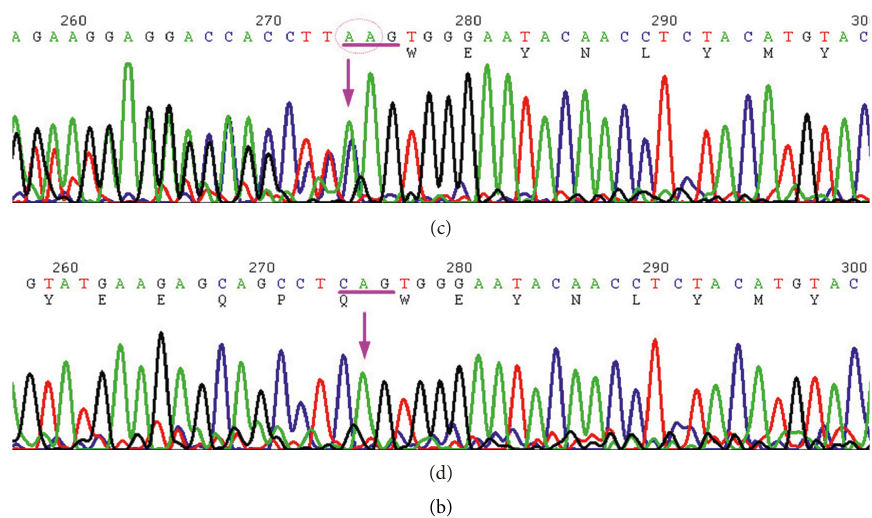
Figure 1: (a) Family map: black carries SCN5A (NM_000335.5) at c.4313dup (p.Trp1439ValfsTer32) mutation, the arrow is the proband, squares indicate males, and circles indicate females. (b) The proband (II1) 24 h ambulatory ECG: sinus rhythm; frequent ventricular extrasystole; intermittent first-degree atrioventricular block; intermittent abnormal ventricular repolarization (brugada wave in lead V1); continuous heart rate deceleration suggests moderate risk. (c) Sanger sequence diagram: c.4313dup (p.Trp1439ValfsTer32) mutant appeared in exon 25 of SCN5A gene. (d) Corresponding wild-type